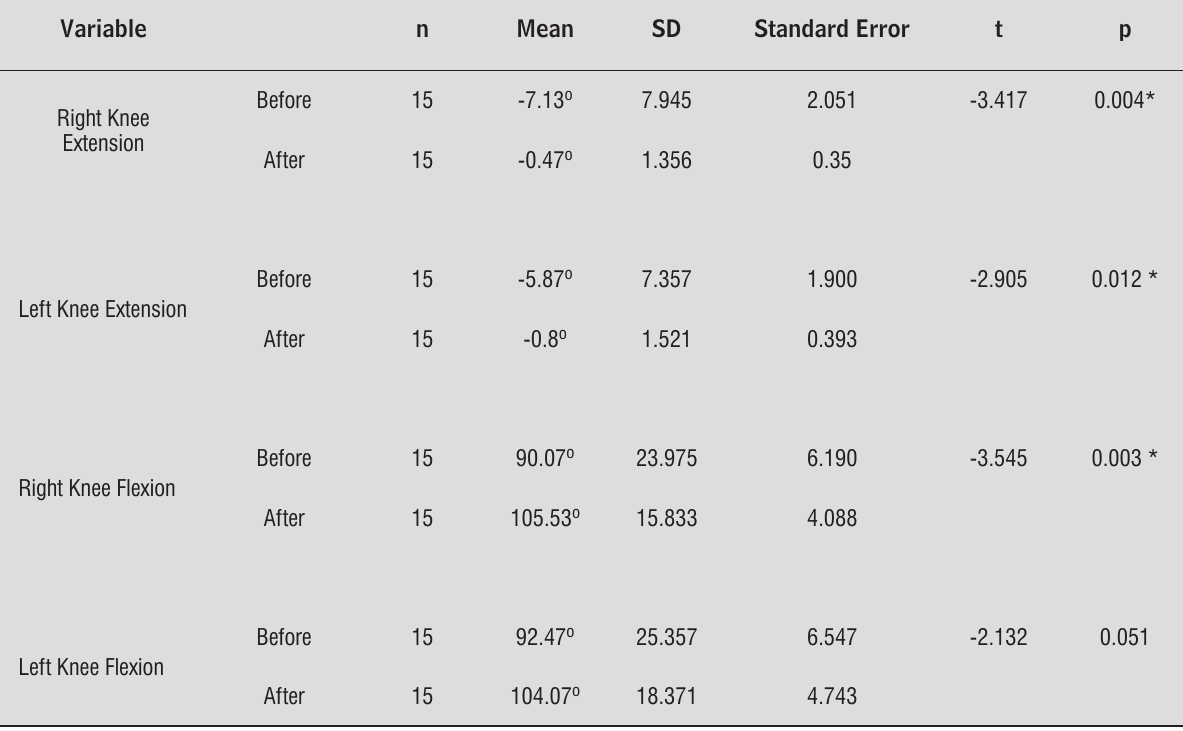
Right Knee Flexion